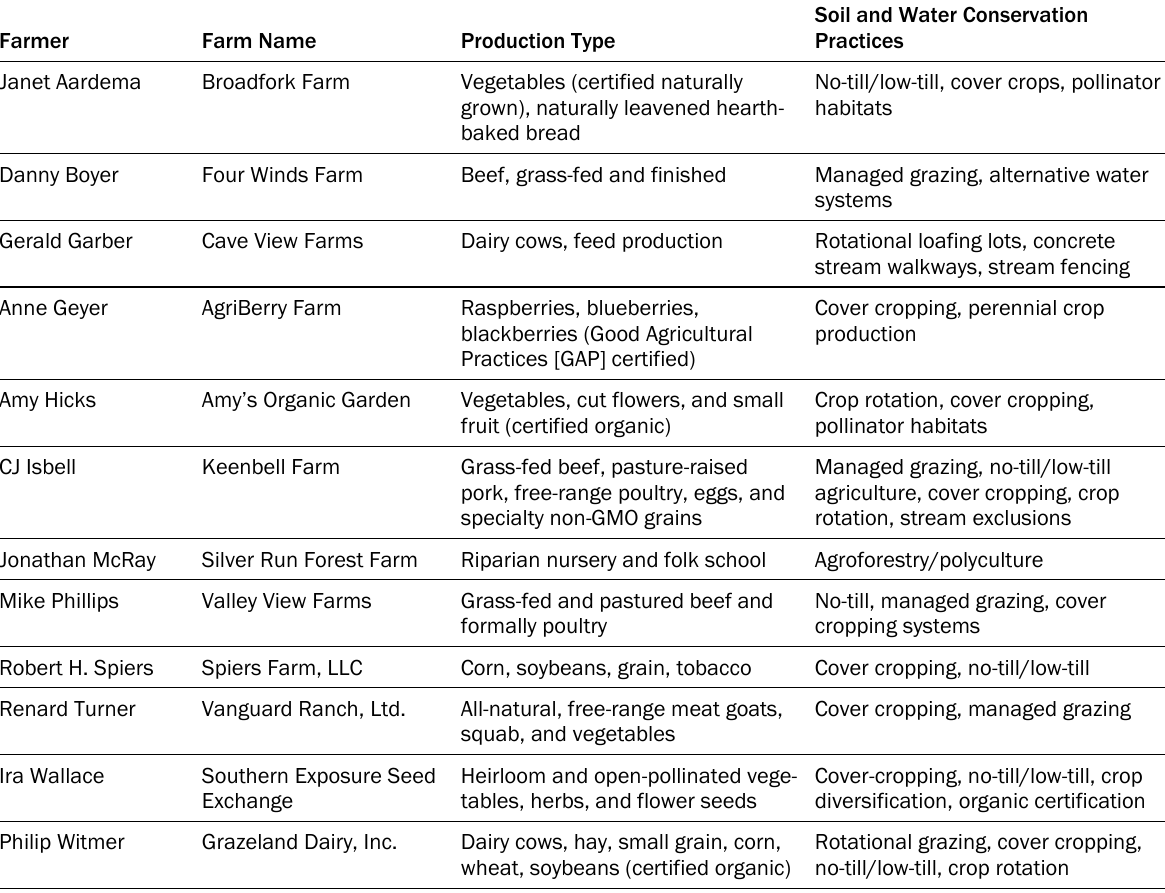
Table 1. Participating Farmers, Type of Production, and Resource Conservation Practices